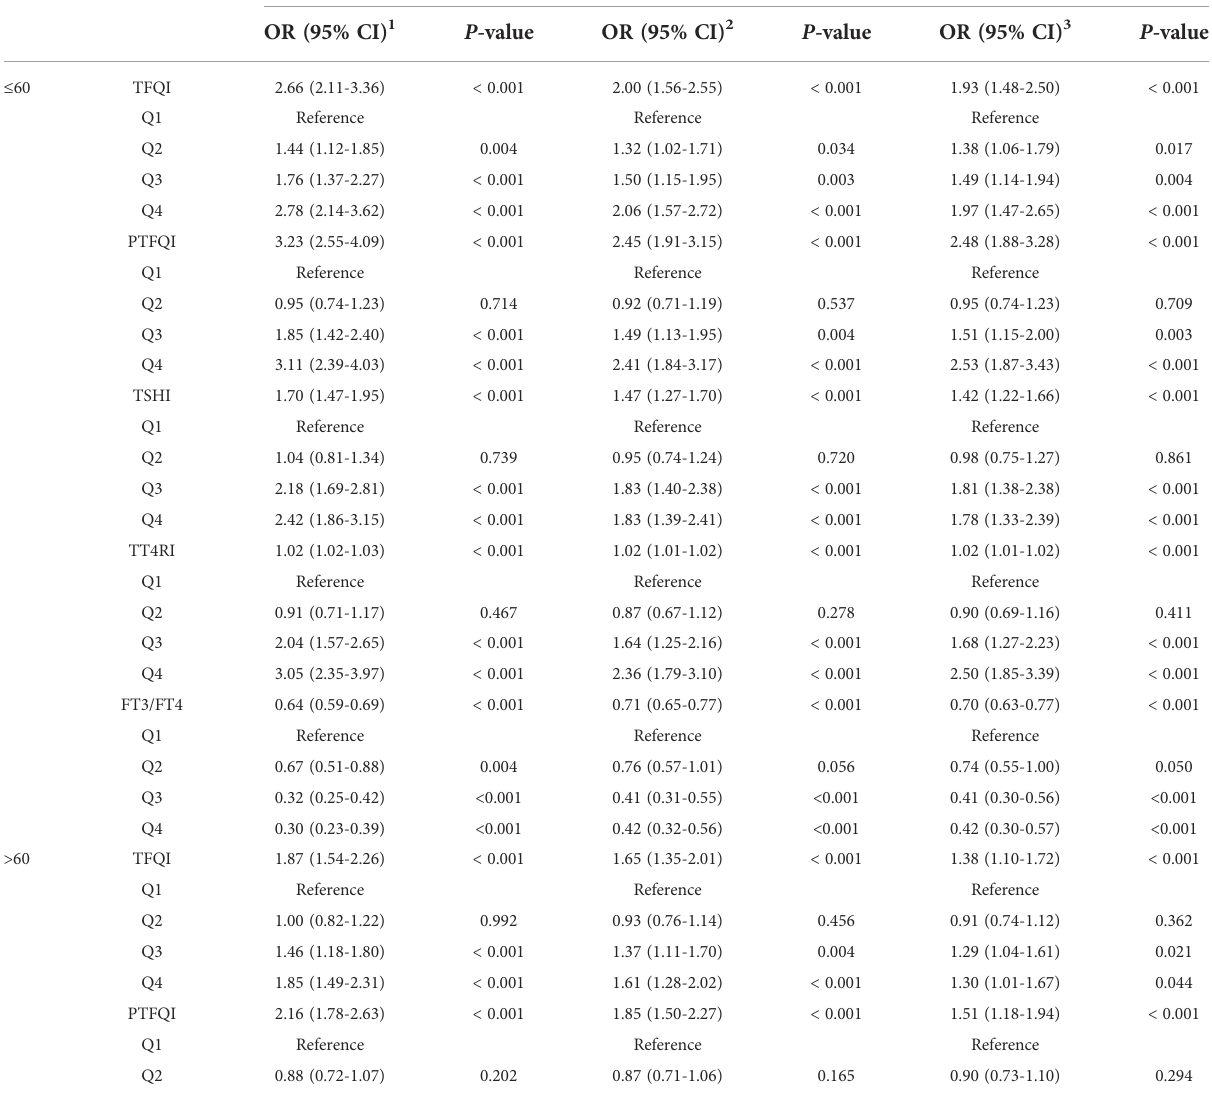
TABLE 4 Association between thyroid hormone sensitivity and carotid plaque according to